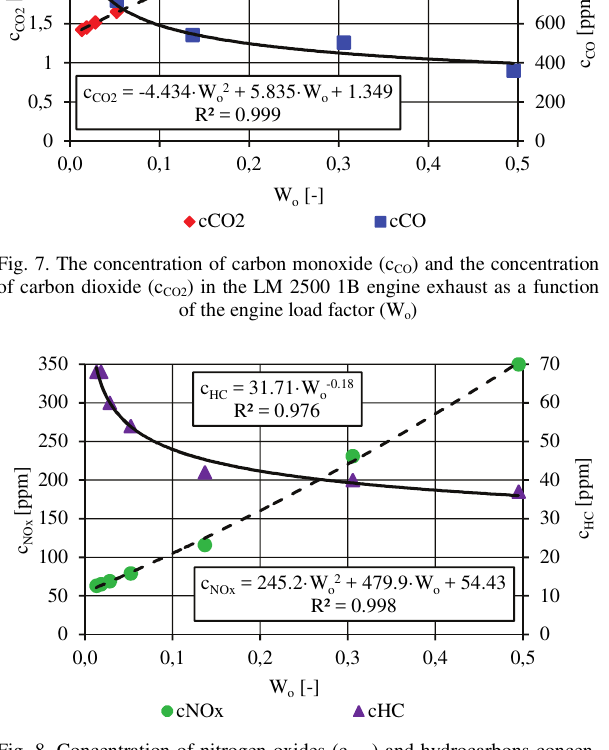
Fig. 8. Concentration of nitrogen oxides (c NOx ) and hydrocarbons concen- tration (c HC ) in the LM 2500 1B engine exhaust as a function of the engine load factor (W o